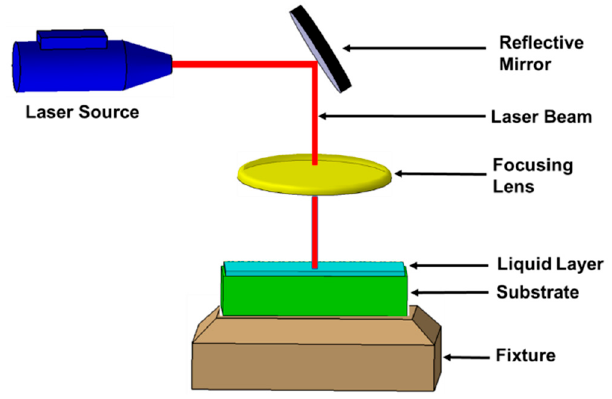
Figure 1. Schematic of Liquid-Assisted Laser Beam Machining Process.